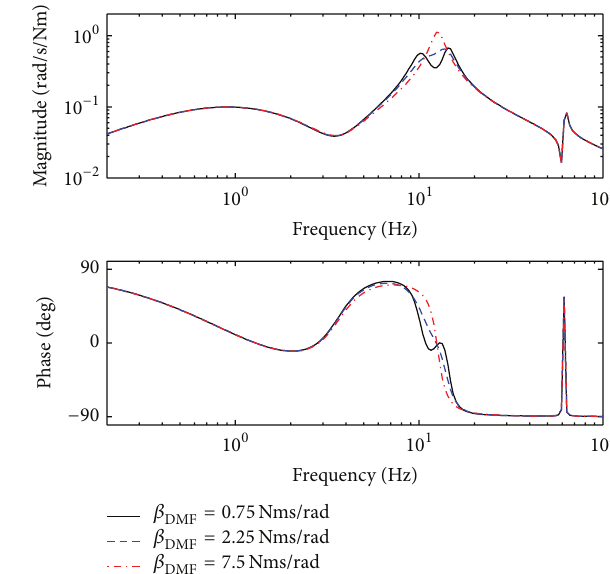
Figure 7: Sensitivity analysis: effect of the DMF damping coefficient ̇𝜃 𝑇 on the FRF 5 / 5